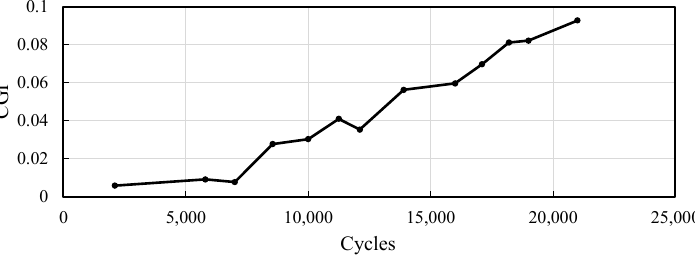
Figure 25. The results of monitored CGI presented [30] for the laboratory bridge girder setup.